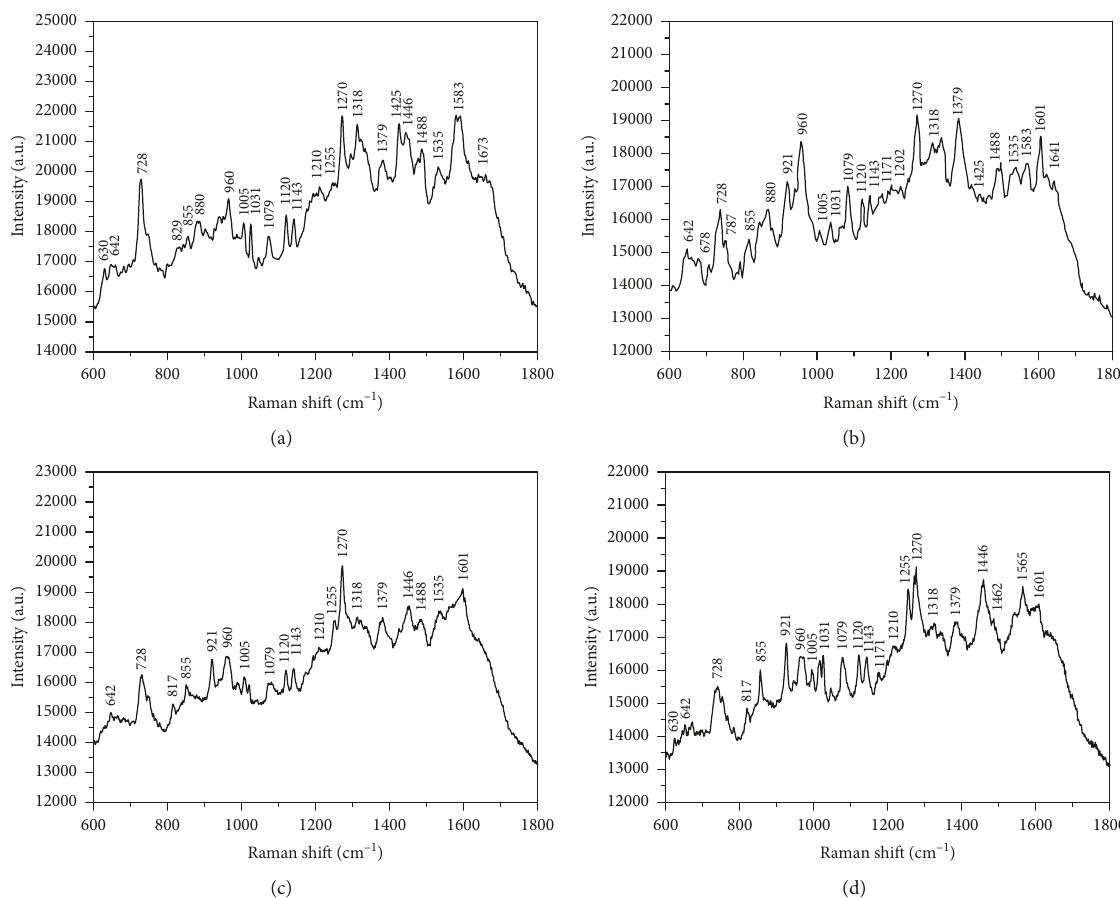
Figure 4: Average SERS spectra of serum obtained from (a) large cell lung cancer patients, (b) lung adenocarcinoma patients, (c) lung squamous carcinoma patients, and (d) healthy subjects.